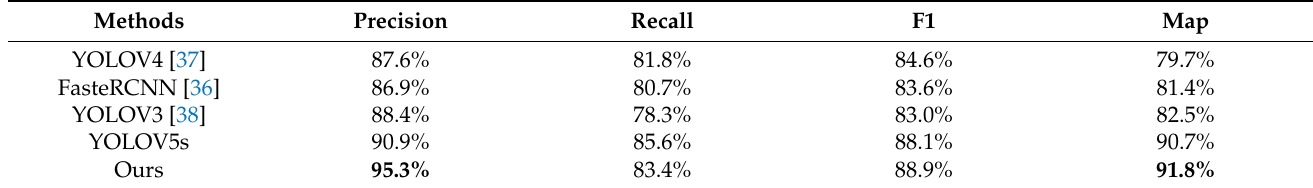
Table 8. The comparison between ours and existing models (self-building